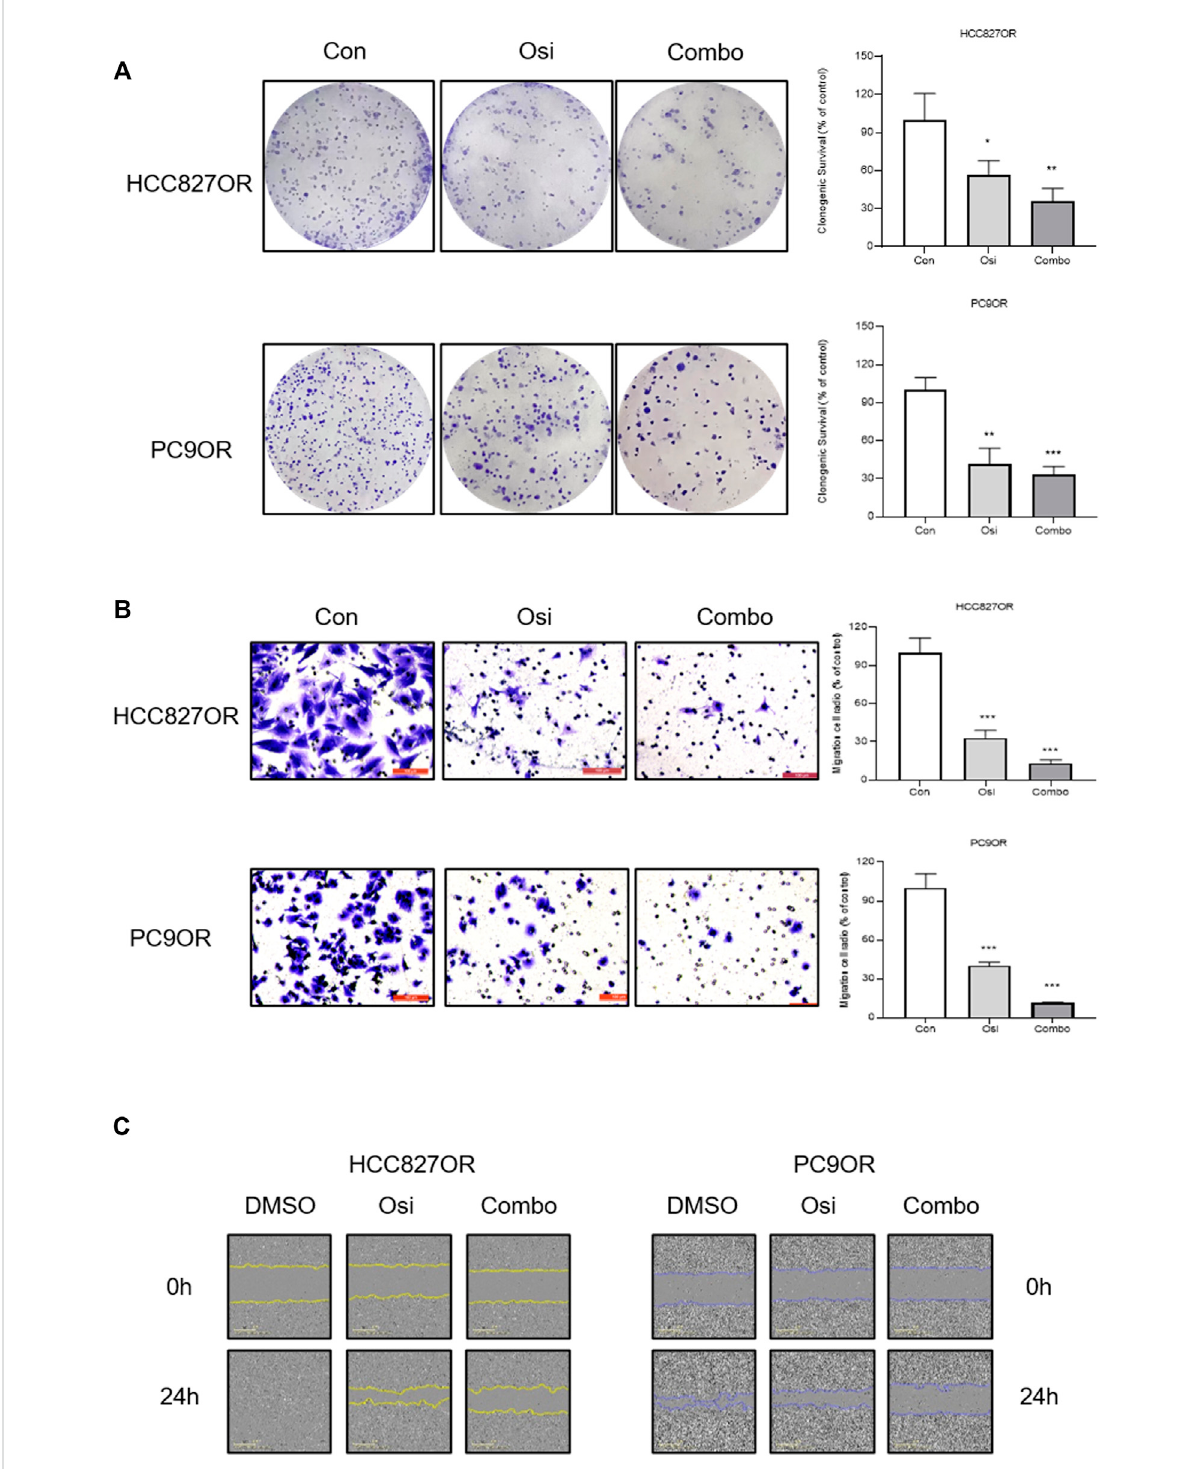
FIGURE 3 The synergistic effect of FYN with osimertinib on cell proliferation and migration. Resistant HCC827 cells were treated with 1 μ M osimertinib aloneorincombinationwith250 μ g/mlFYN.ResistantPC9cellsweretreatedwith1 μ Mosimertinibaloneorincombinationwith125 μ g/mlFYN. (A) ClonogenicassaysresultsofHCC827ORandPC9ORandthecellsweretreatedfor14days. (B) Cellmigrationwasdetectedbytranswellassaysor (C) wound healing assays for 24 h. Con, control; Osi, osimertinib; Combo, combination of Feiyanning Formula with osimertinib. * p < 0.05, ** p < 0.01, *** p <